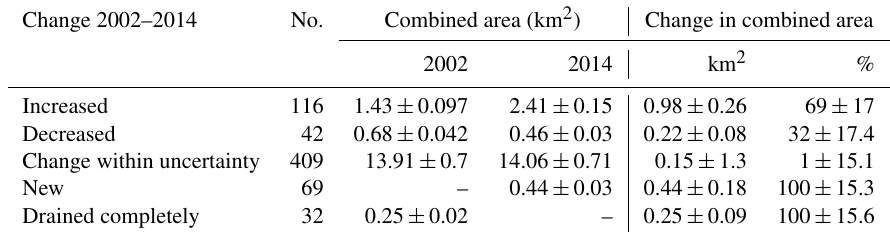
Table 3. Changes in number and the combined areas of lakes.